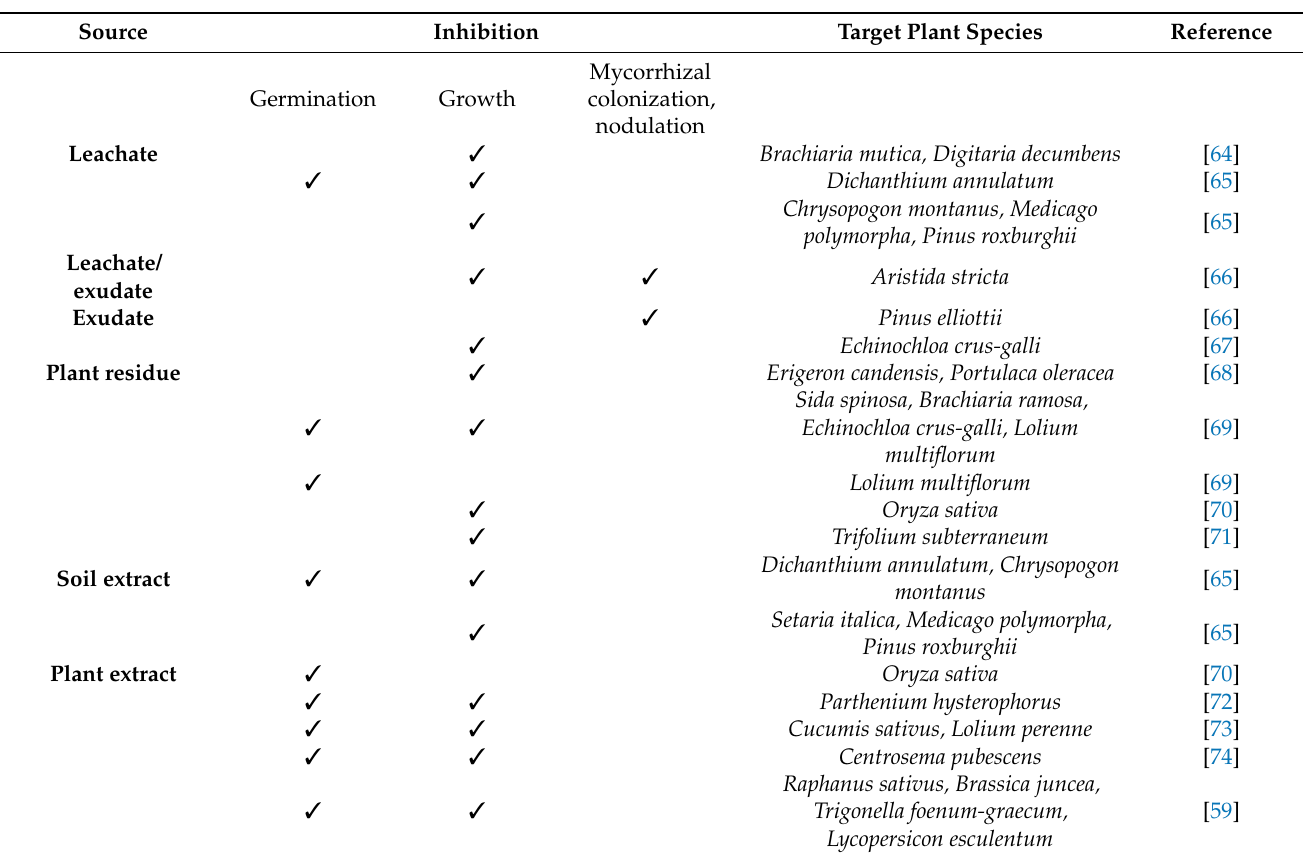
Allelopathic activities of leachates, exudates, residues, soil and plant extracts of Imperata cylindrica